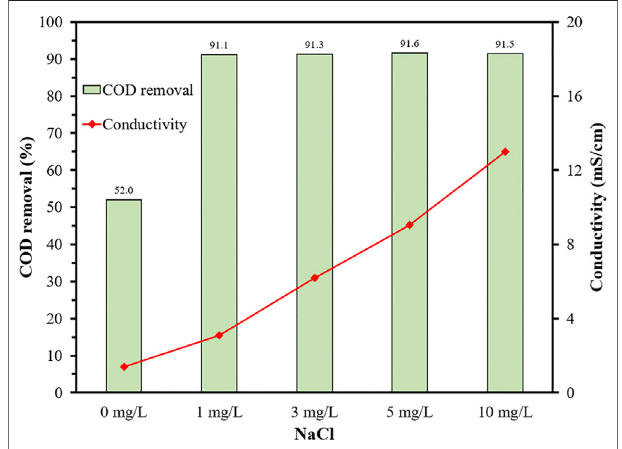
FIGURE 4 | COD removal ef fi ciency of the stirring EC system with different NaCl concentrations and conductivity values at 60 min of detention